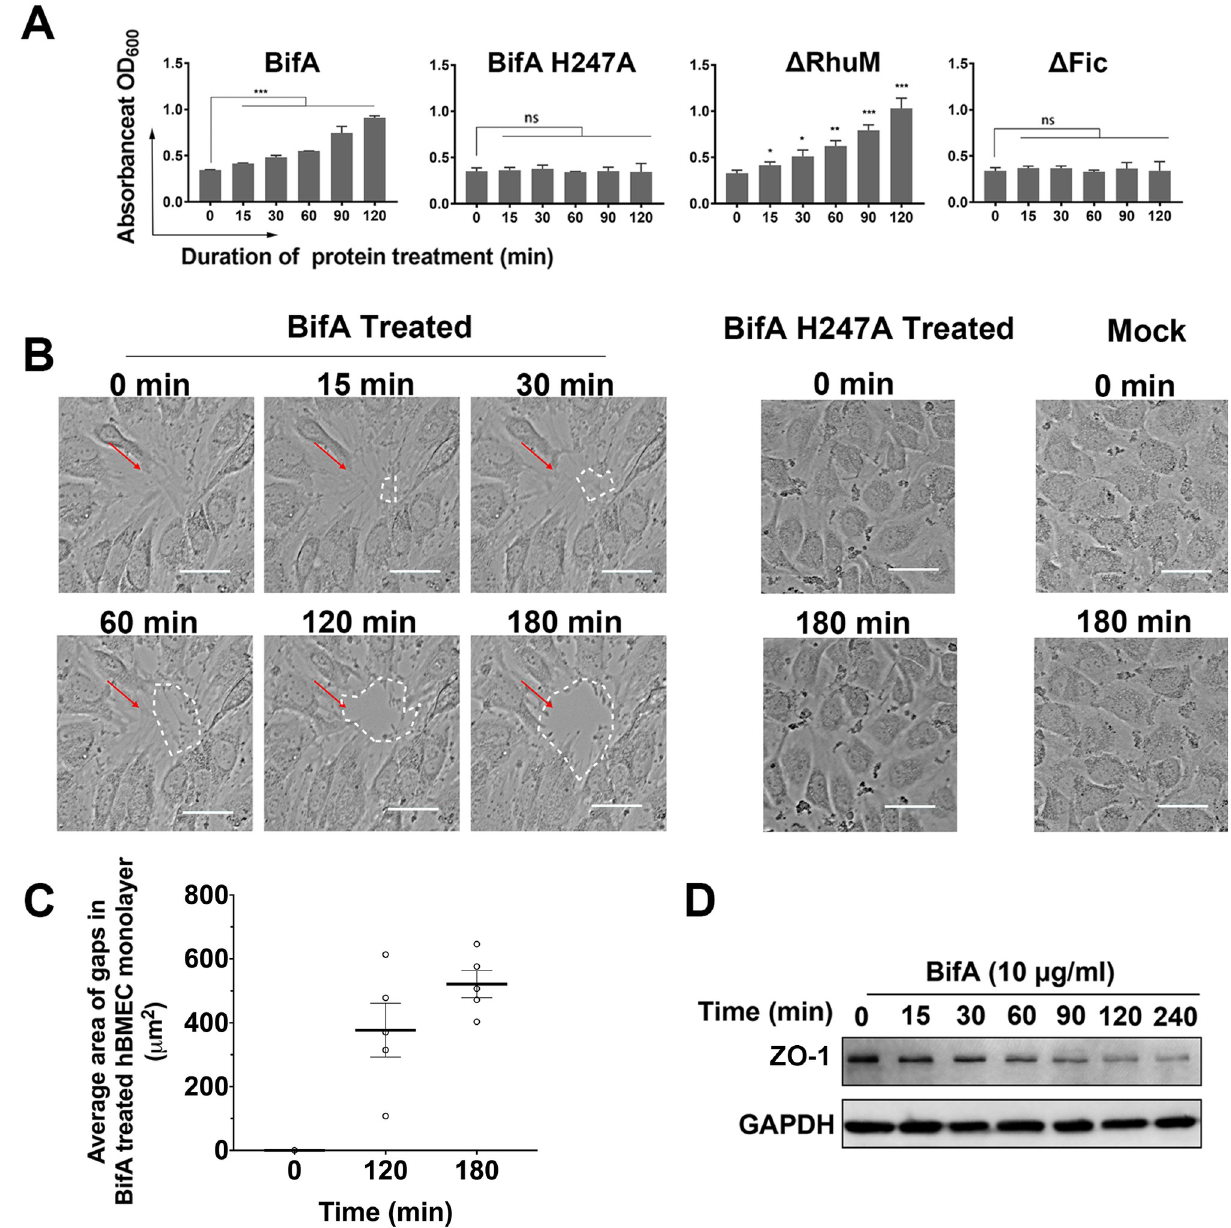
Fig 3. BifA disrupts hBMEC monolayer barrier function. (A) Transwell-grown hBMECs were treated with purified BifA or its variants and assessed for barrier integrity with an Evans Blue dye penetration assay (quantitated by absorbance at OD 600 ) (results are from 3 experiments, � indicates p-value < 0.05, �� indicates p-value < 0.01, ��� indicates p-value < 0.001 with t test). (B) Time-lapse microscopy of hBMEC monolayers following addition of purified BifA, BifA H247A, or mock treatment with DMEM. Scale bar = 50 μ m. For the movies, see supplemental video (S1–S6 Movies). (C) Quantitation of gap size in S2 Movie (using Image J) detected in monolayers 2 and 3 hours after treatment with BifA. (D) Immunoblot detection of ZO-1 in lysates of hBMEC after BifA treatment. GAPDH was used as reference protein. Δ RhuM truncation variant, but not with the H247A BifA or Δ Fic variants (Fig 4B). Thus, BifA’s interaction with moesin in hBMEC cells appears to depend on its Fic domain. Similar co-IP experiments were carried out using cells transfected with tagged variants of moesin (Fig 4C), to determine which of the moesin domains is required for BifA interaction. BifA co-IPed